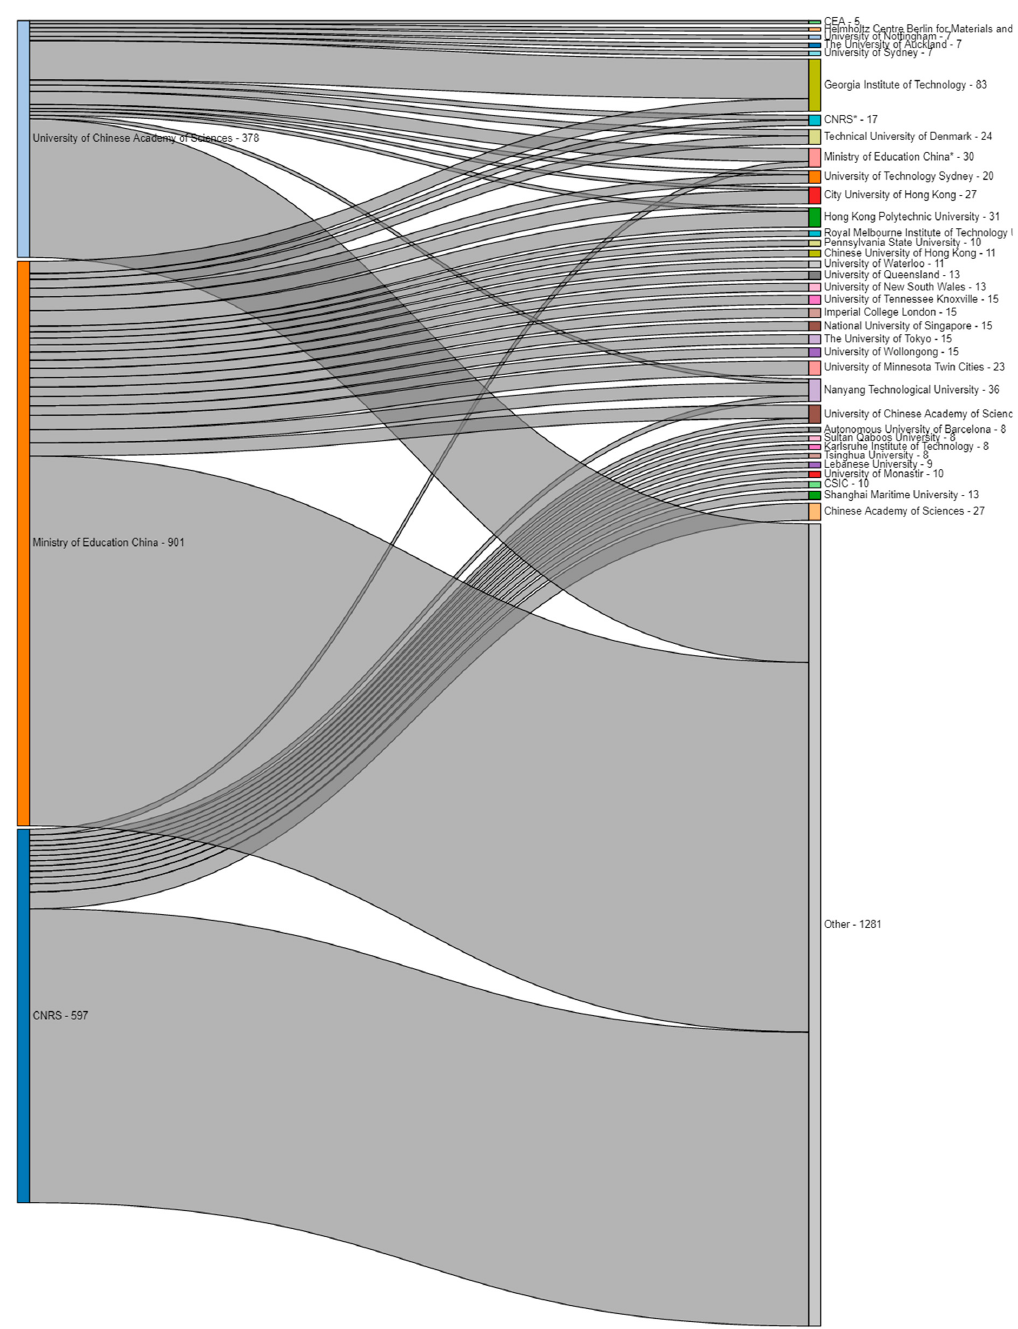
Figure 4. Top networks that appear within renewable energy, sustainability and the environment, 2020–2021 (Based on the SciVal database (www.scival.com, accessed on 7 April 2021); data source: Scopus (downloaded on 7 April 2021); copyright: Elsevier B.V.).